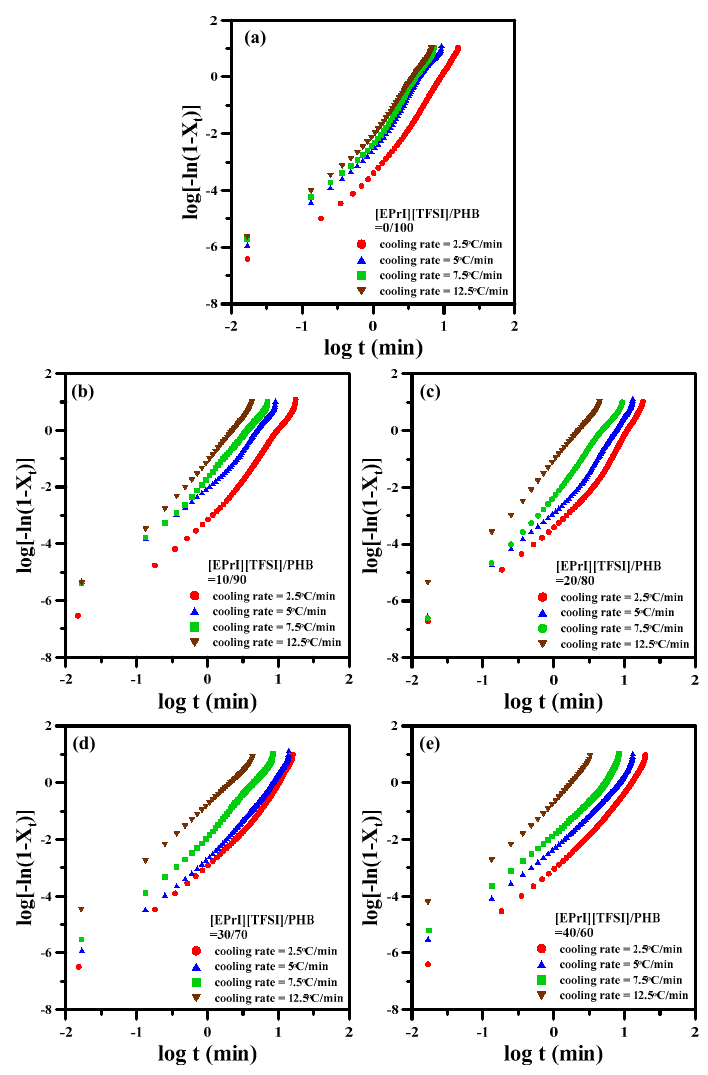
Figure 7. Avrami plots of log[ − ln(1 − X t )]-v.s.-log( t ) for the non-isothermal crystallization of [EPrI][TFSI]/PHB blends with different compositions: ( a ) 0/100; ( b ) 10/90; ( c ) 20/80; ( d ) 30/70; and ( e ) 40/60.